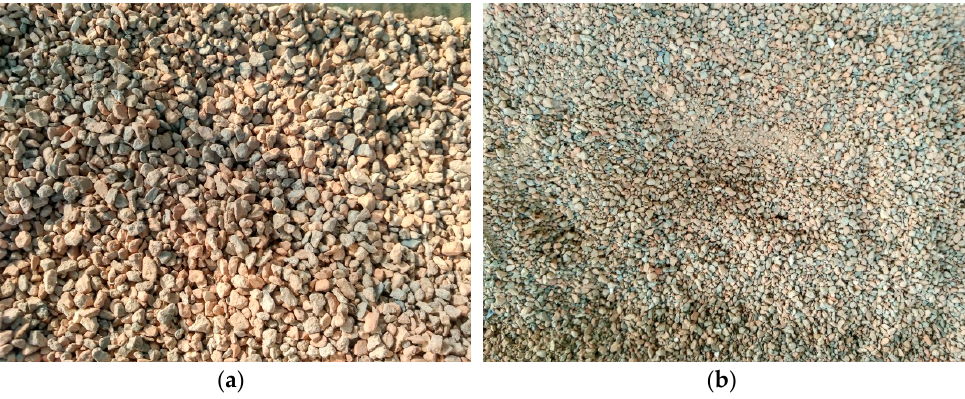
Figure 1. The aggregate of RAC: ( a ) the coarse aggregate size is 5–10 mm; and ( b ) the fine aggregate size is 0–5 m.